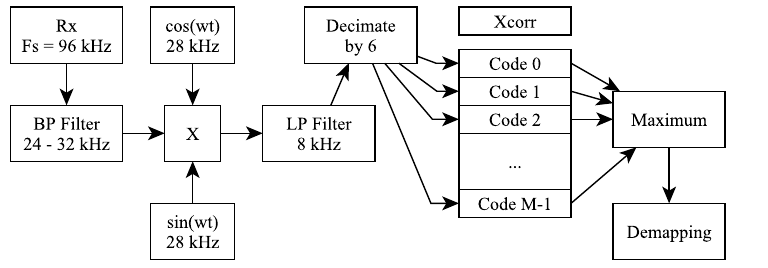
Figure 3. Block Diagram for Ideal Receiver Design.